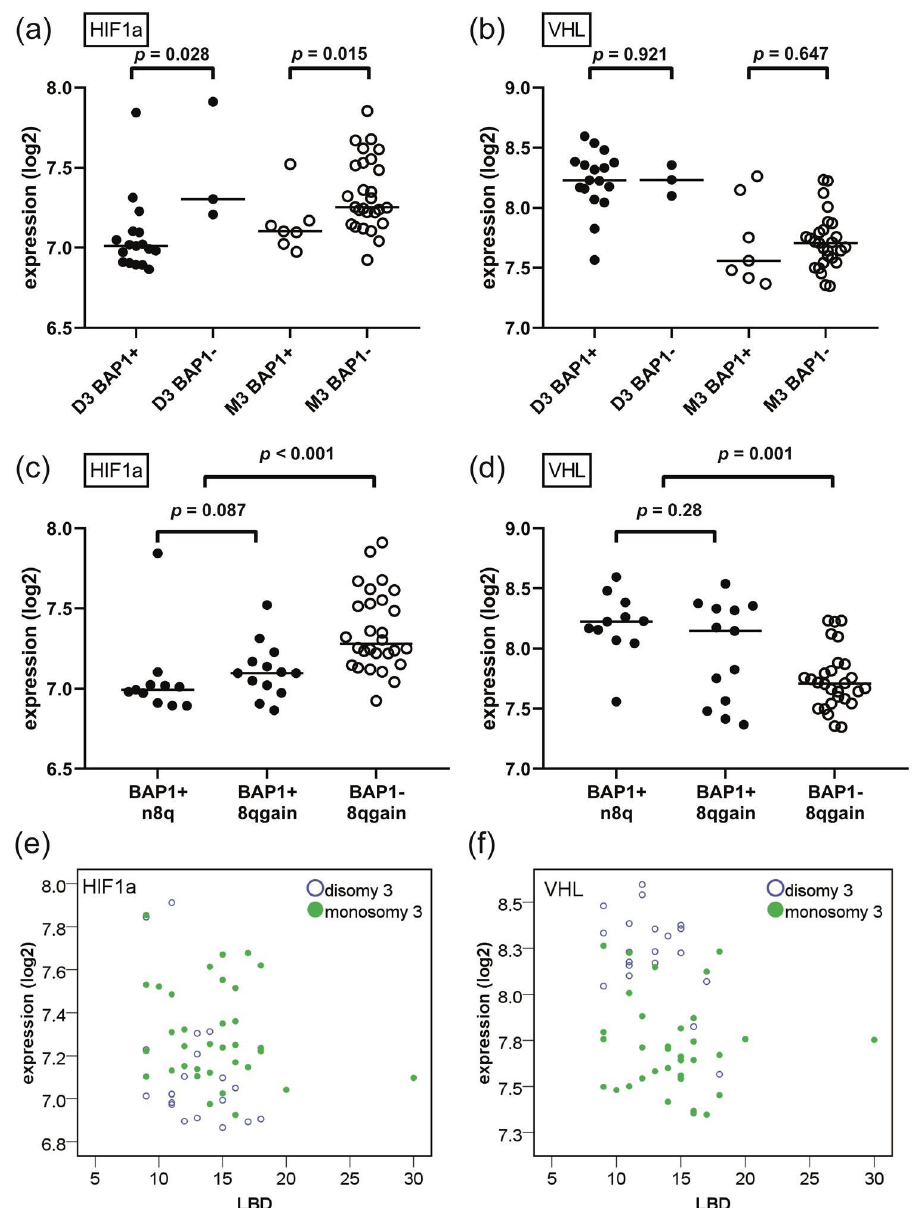
Figure 2. Expression of hypoxia-inducible factor 1-alpha (HIF1a) and von Hippel–Lindau (VHL) mRNA in relation to chromosome status and BRCA1 -associated protein 1 (BAP1) loss. ( a ) HIF1a expression is significantly increased with BAP1 loss in both disomy 3 (D3) and monosomy 3 (M3) tumours. ( b ) VHL expression is strongly dependent on chromosome 3 status, but is not dependent on BAP1 status within D3 or M3 tumours. ( c ) HIF1a expression is not increased with the early event of 8q gain, but is increased with the later event of BAP1 loss ( n = 52, excluding two cases of BAP1-n8q). ( d ) As with HIF1a, VHL expression is not dependent on early events as 8q gain, but is decreased with later events as loss of BAP1 ( n = 52, excluding two cases of BAP1-n8q). ( e ) Adjusted for status of chromosome 3, there is no significant relationship between largest basal diameter (LBD) and expression of HIF1a. ( f ) Adjusted for status of chromosome 3, there is no significant relationship between LBD and expression of VHL. (Abbreviations: BAP1+, BAP1-positive; BAP1−, BAP1-negative; n8q, normal chromosome 8q; 8qgain, gain of chromosome 8q; LBD, largest basal diameter; D3, disomy 3; M3, monosomy